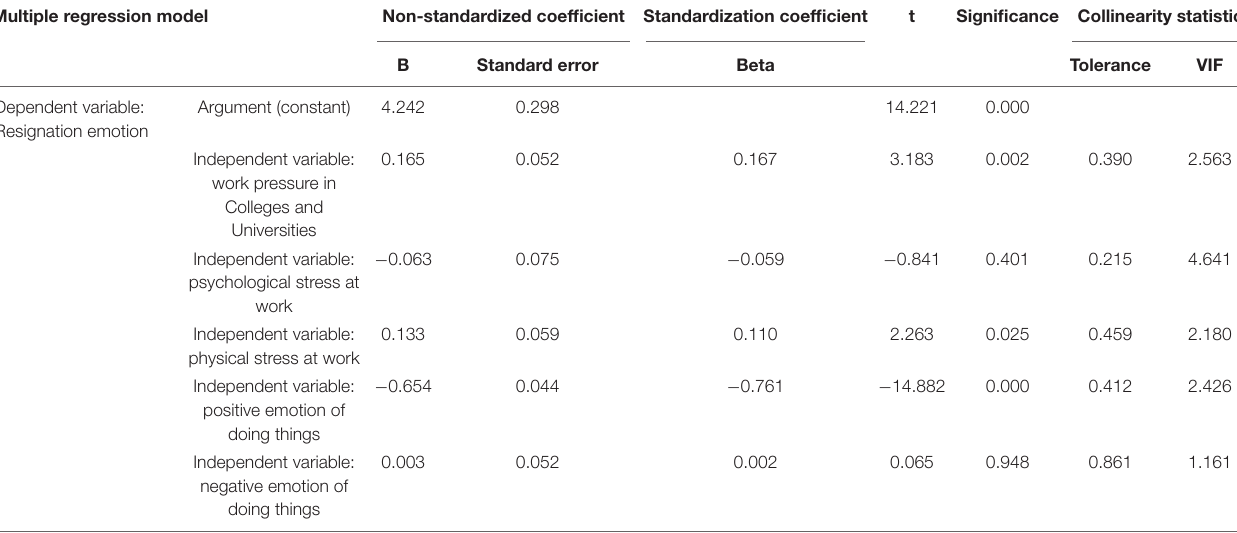
TABLE 2 | Coefficients of multiple linear regression model of resignation psychology of interviewed college teachers. Multiple regression